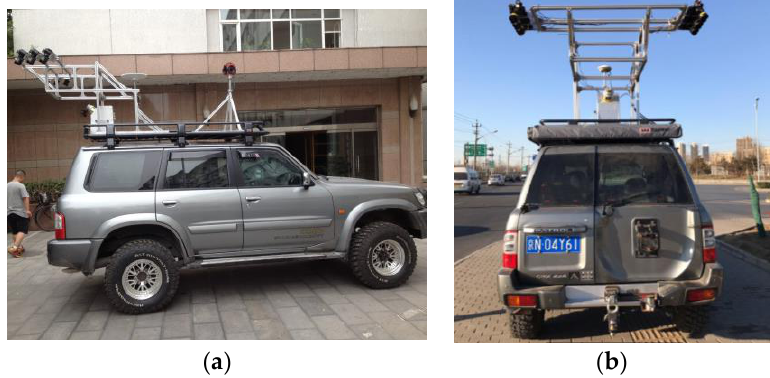
Figure 1. Modified mobile-mapping system. ( a ) Side view. ( b ) Back view.